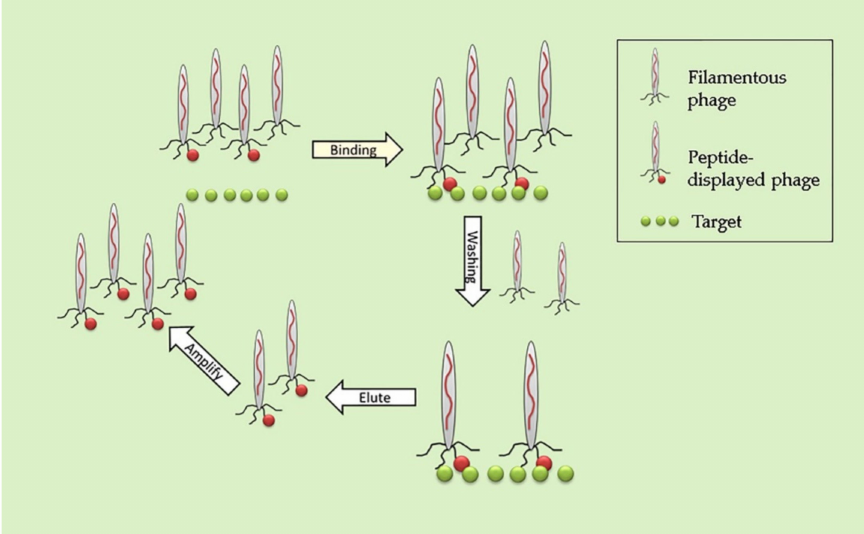
Figure 2. Screening of a phage-displayed random peptide library using a protein as